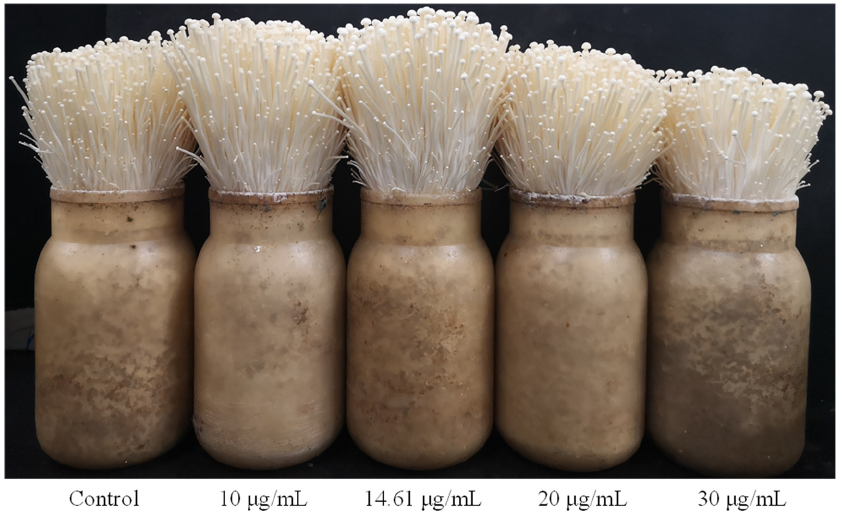
Figure 4. Fruiting body growth of F. filiformis treated with chitosan. Table 4. Effects of different concentrations of chitosan on lysine content and growth rate in fruiting bodies of F. filiformis.